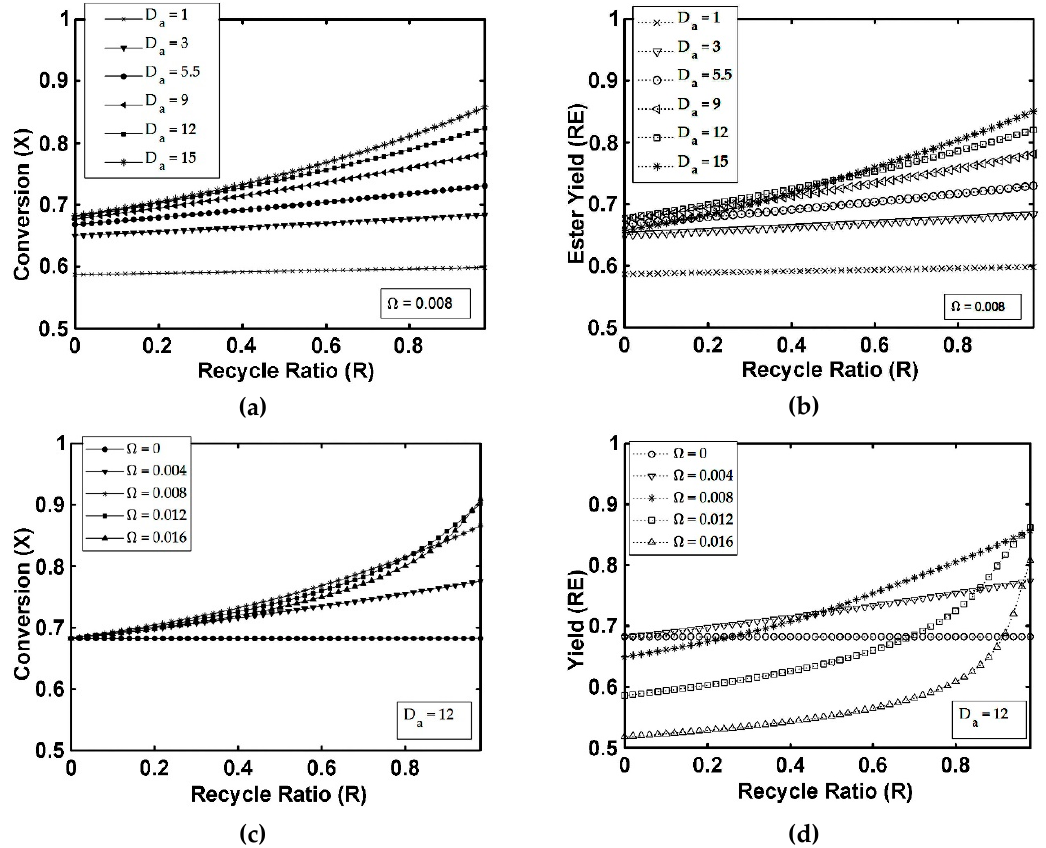
Figure 5. Influence of the R recycle ratio on isoamyl alcohol conversion and on the ester yield in a SR+PVMU ( Configuration 2 ), as a function of the Ω membrane area to the reactor volume ratio ( a , b ) and the D a Damköhler number ( c , d